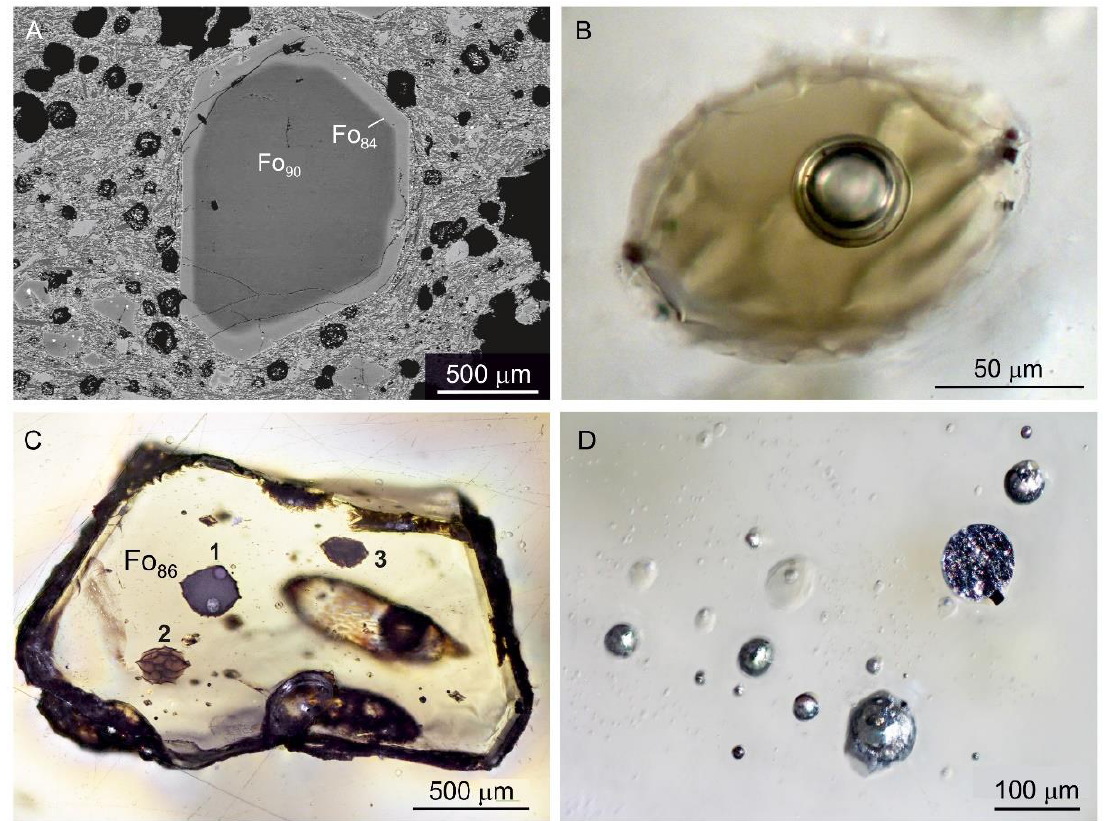
Figure 1. Back-scattered electron ( A ) and transmitted light ( B – D ) images of Tolbachik high-Mg basalts and melt inclusions. ( A ) The texture of the 1941 Tolbachik basalt, comprising large, normally zoned olivine phenocrysts (center) surrounded by a porous groundmass. ( B ) Large, 150-µm sized glassy melt inclusion with a shrinkage bubble partially filled with H 2 O-rich fluid. ( C ) Olivine crystal with several glassy and crystallized melt inclusions, containing high sulfur: 1–0.91 wt.% S, the inclusion is opaque and contains fine crystallites of clinopyroxene and anhydrite; 2 and 3—glassy (translucent) melt inclusions with 0.51–0.61 wt.% S. See Figure 5 for more detail; the different appearance of MI in a single olivine crystal is explained below. ( D ) A swarm of sulfide inclusions in an olivine crystal. In addition to sulfides, the crystal contains glassy melt inclusions, but without sulfide globules. One of the sulfide globules is exposed on the polished